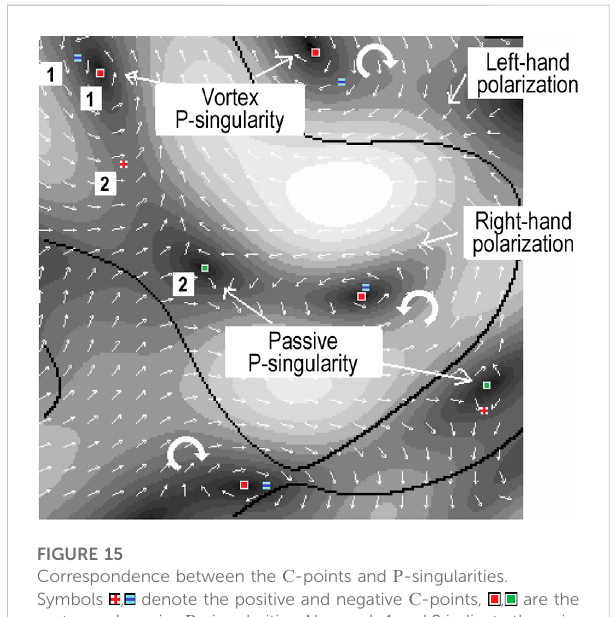
FIGURE 15 Correspondence between the S -points and R -singularities. Symbols , denote the positive and negative S -points, , are the vortex and passive R -singularities. Numerals 1 and 2 indicate the pairs of associated C- and R -singularities. Local directions of the Poynting vector are indicated by arrows, black lines are the s-contours, background shows the grayscale-encoded intensity distribution with dark